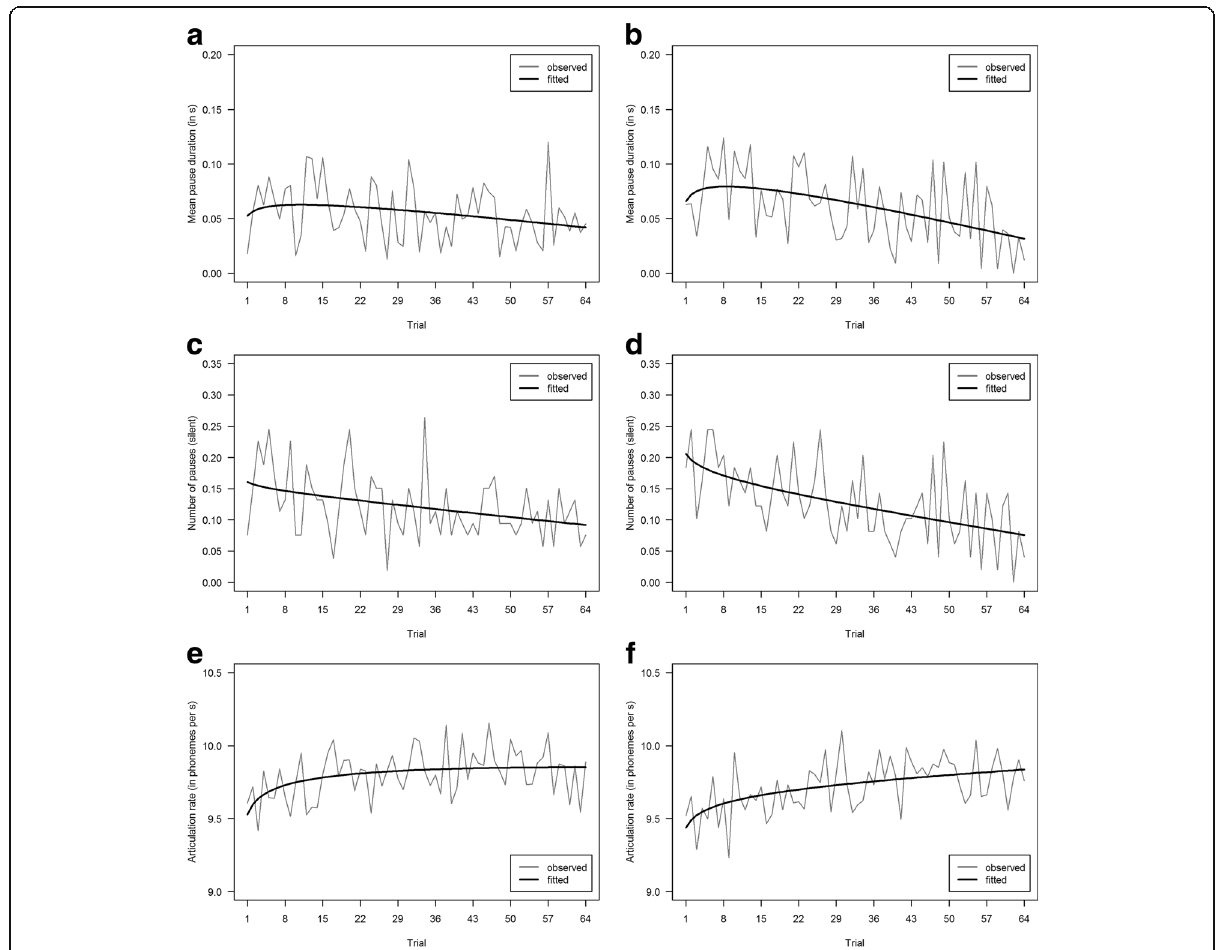
Fig. 6 Observed and fitted logarithmic progressions of speech-related parameters computed per trial in easy ( a , c , e ) and difficult ( b , d , f ) conditions. Graphs in the first row refer to mean pause duration (total duration of silent pauses in seconds divided by the number of silent pauses). Graphs in the second row refer to the number of pauses (only silent pauses). Graphs in the third row refer to articulation rate (number of phonemes per second excluding